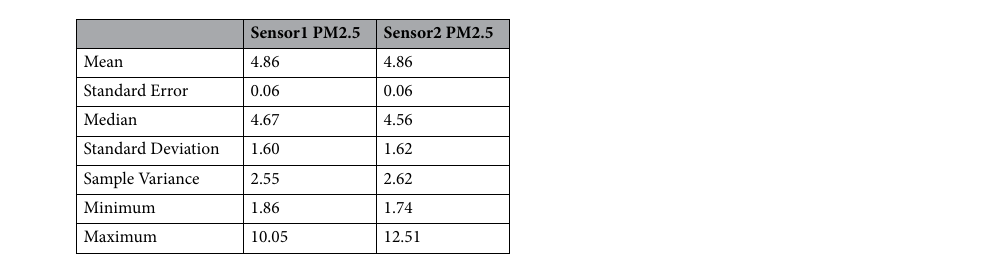
Table 2. Summary statistics of PM2.5 (g/ m 3 ) values recorded by two CoSense